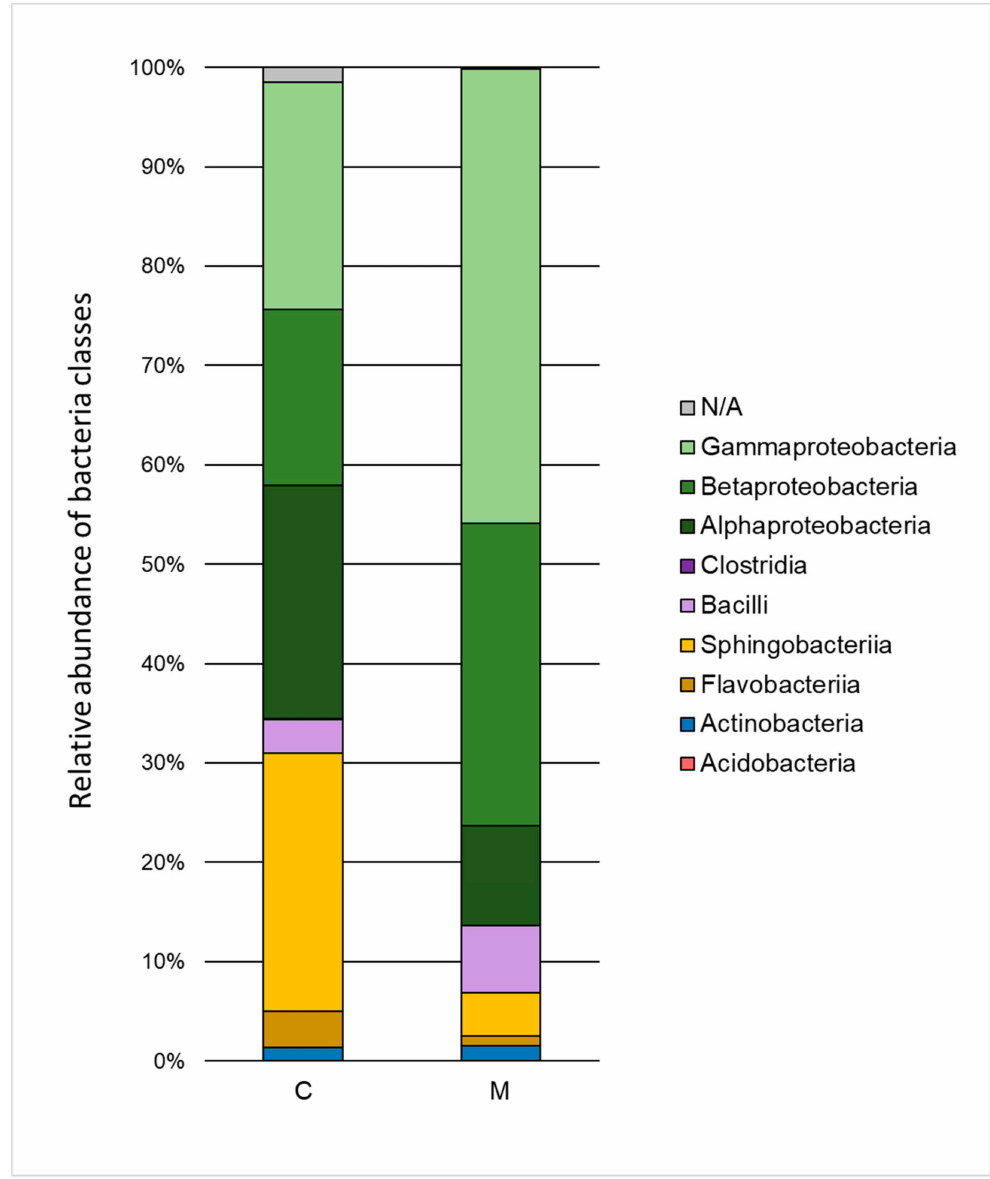
Figure 3. Relative abundance of bacterial classes in the control sample (C) and in a sample containing 150 mg · L − 1 of heavy metals (M) after 168 h of the biodegradation